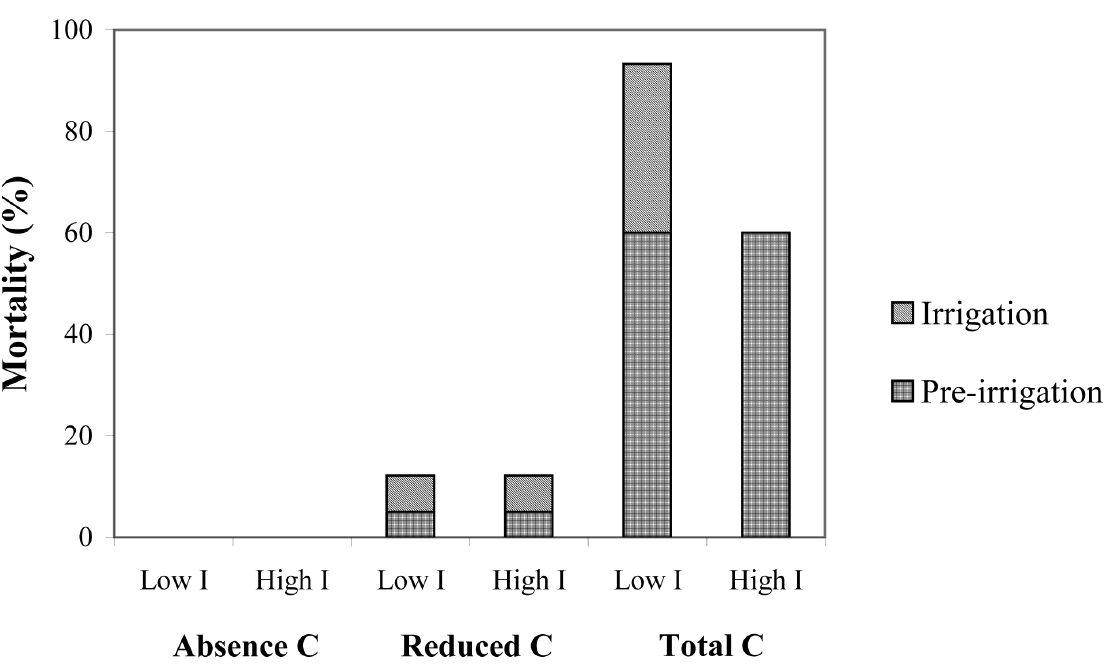
Fig. 3. Percentage mortality of the planted Q. coccifera seedlings under the various experimental conditions (absence of competition, reduced competition, total competition, and low or high irrigation) at two stages of the experiment (before and after differential irrigation treatments). Notes: the percentages after the irrigation treatment exclude the sacrificed seedlings at the end of the pre- irrigation period; mortality was 0 in Absence of competition; during the pre-irrigation period, mortality bars are by definition identical in the “low” and “high” irrigation